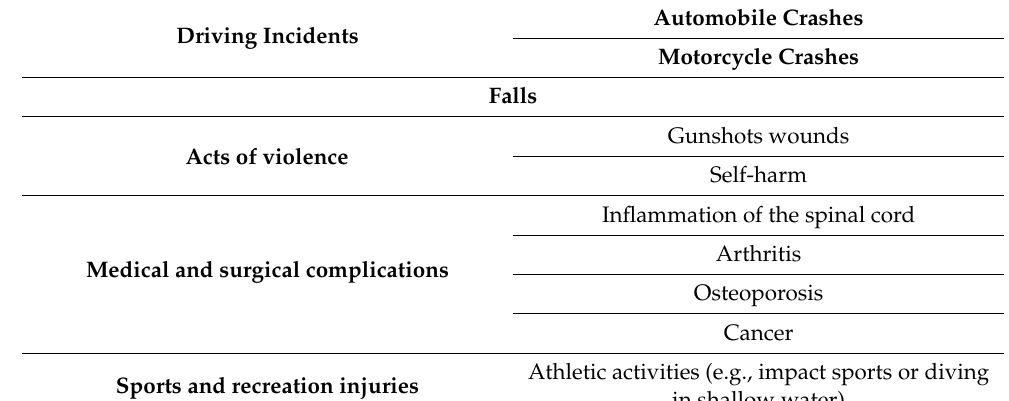
Table 1. Common causes of SCI in general population according to World Health Organization (WHO)